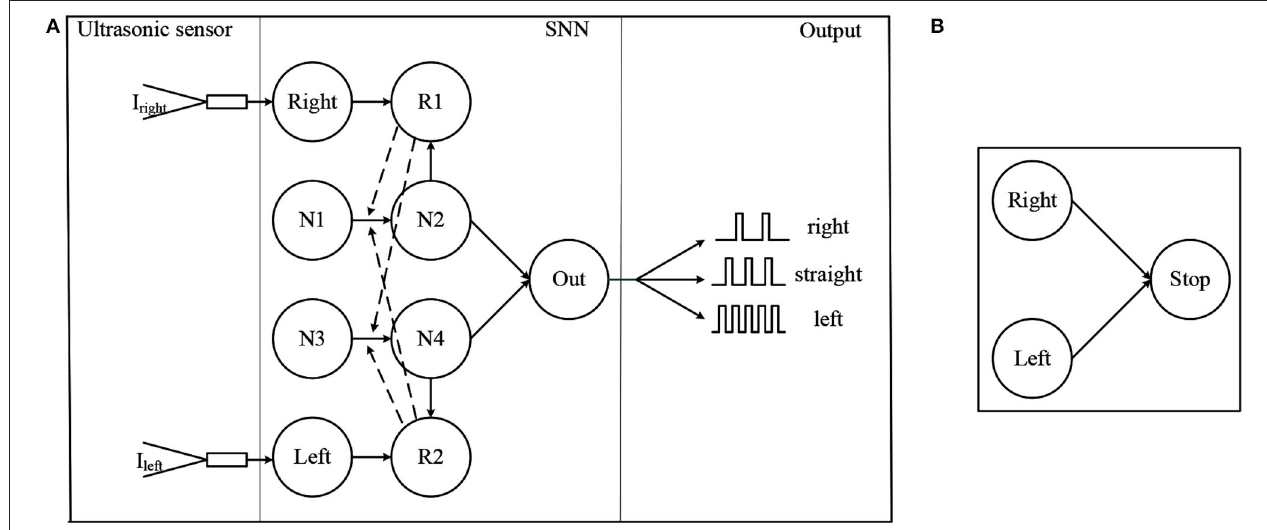
FIGURE 4 | The proposed SNN, where (A) is the obstacle avoidance part and (B) is the brake part.